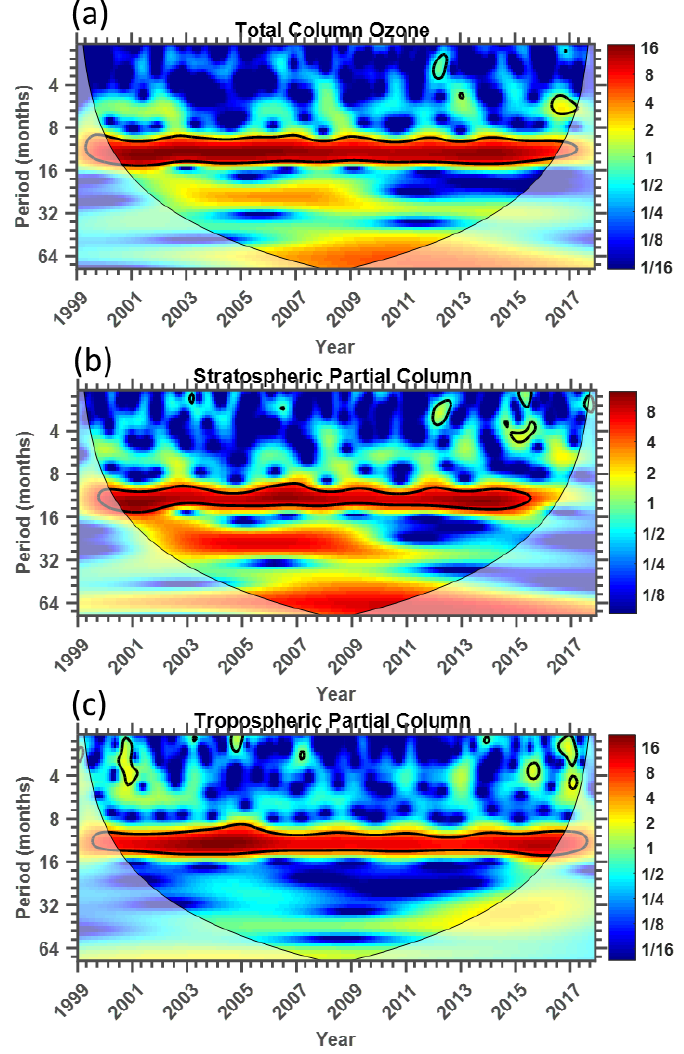
Figure 8. Wavelet and global power spectra obtained by applying the Morlet wavelet to ( a ) total column ozone (TCO), ( b ) stratospheric partial column (SPC), and ( c ) tropospheric partial column (TPC) time series. The black contour encloses regions of greater than the 95% confidence level and the U-shaped curve indicates the cone of influence.